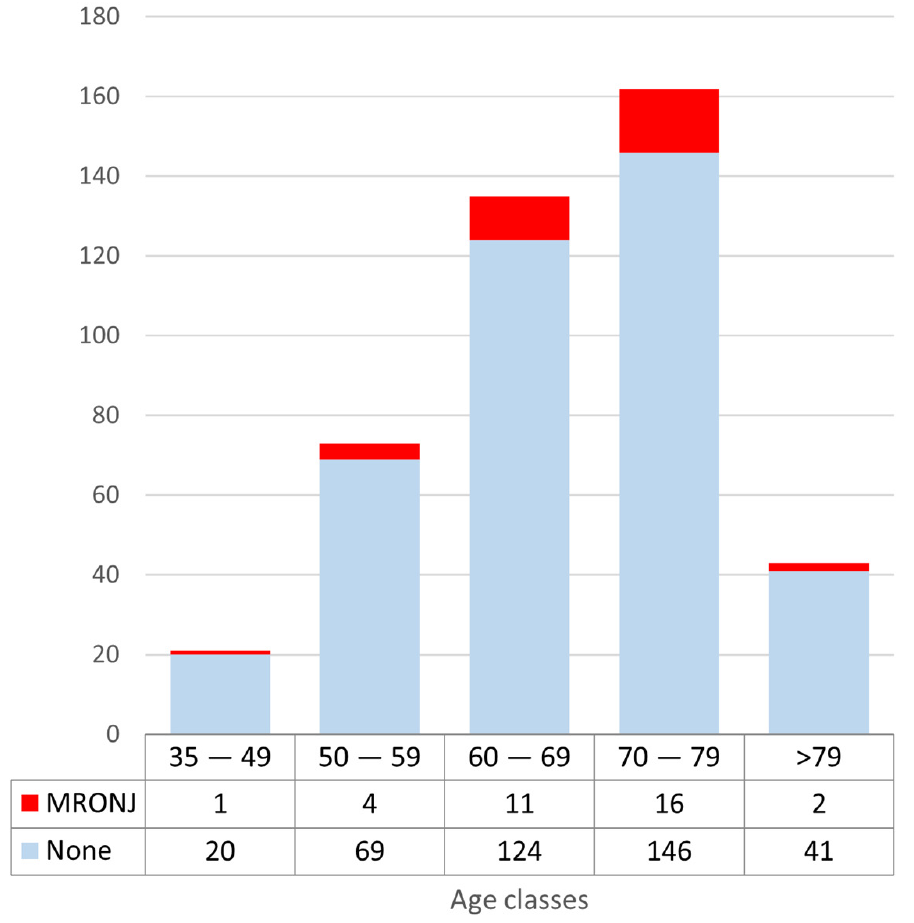
Figure 2. MRONJ incidence by age